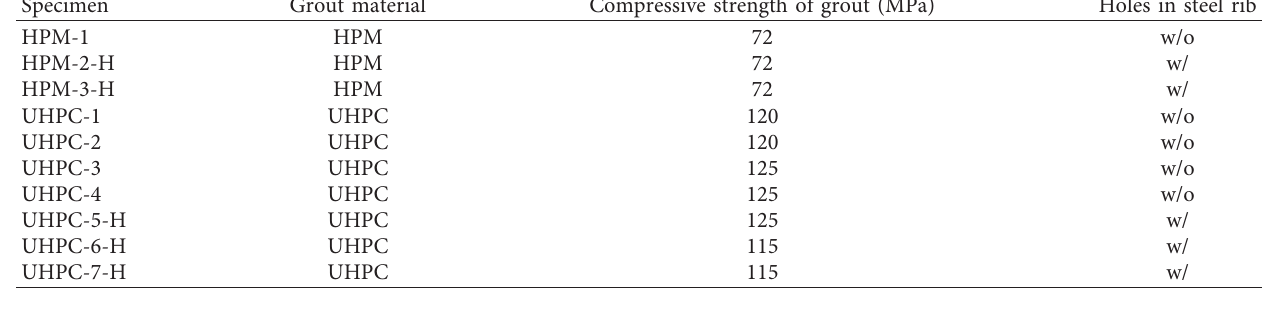
Table 2: Parameters of adhesive shear connectors.